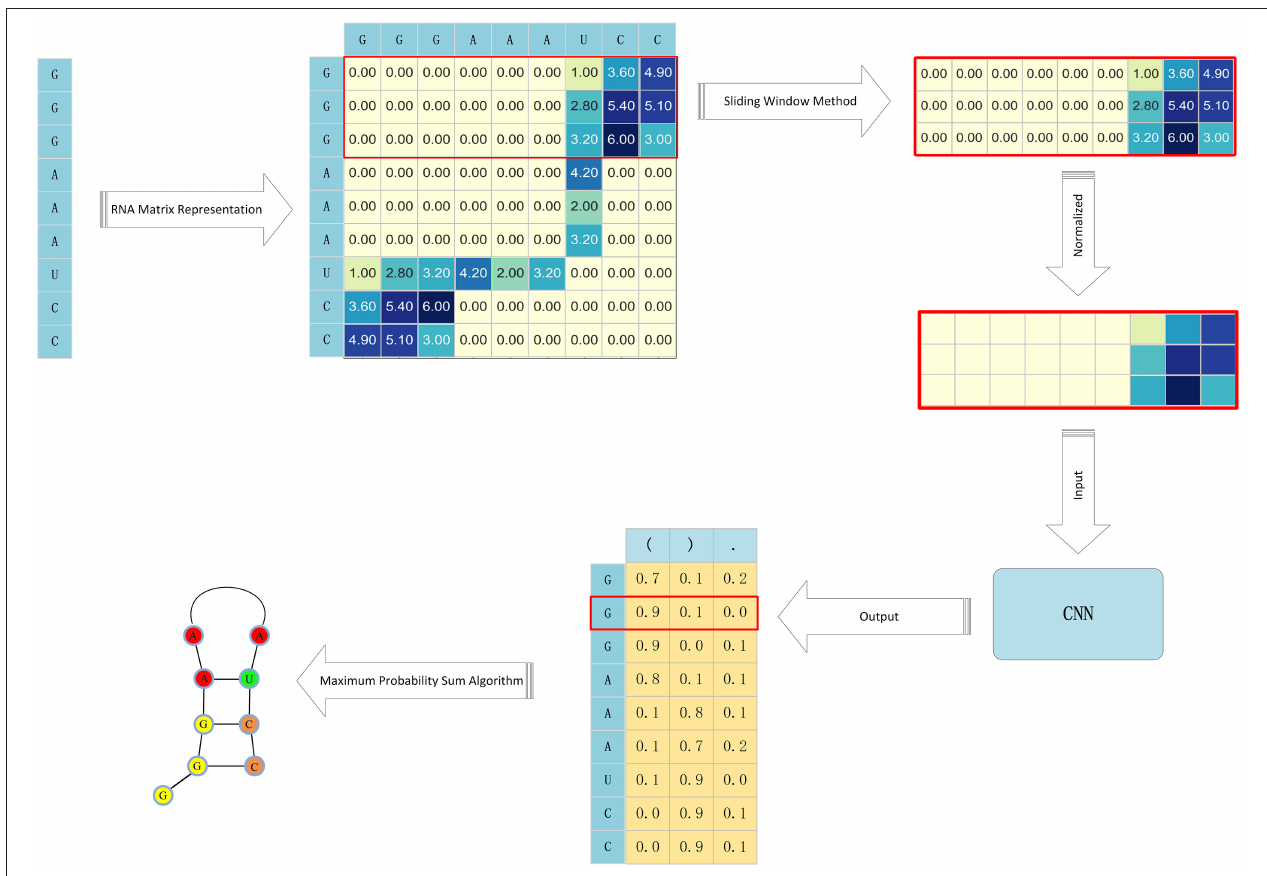
FIGURE 1 | The process of